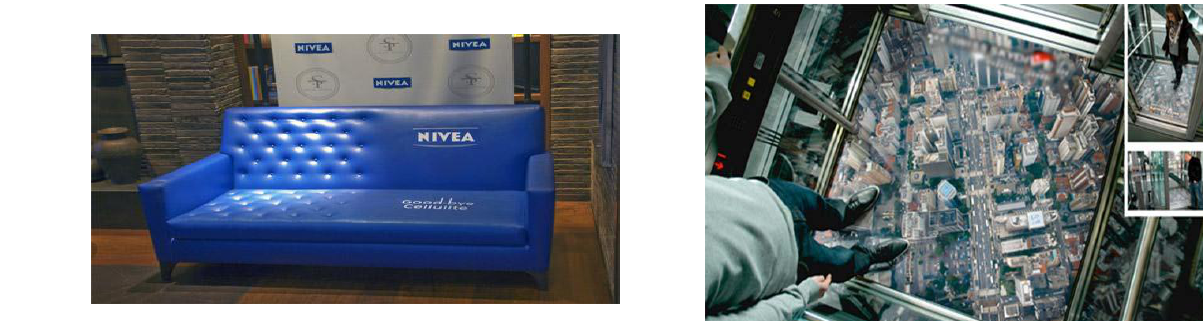
Figure 1. Nivea; If you have a smooth skin, sit on the side of Nivea